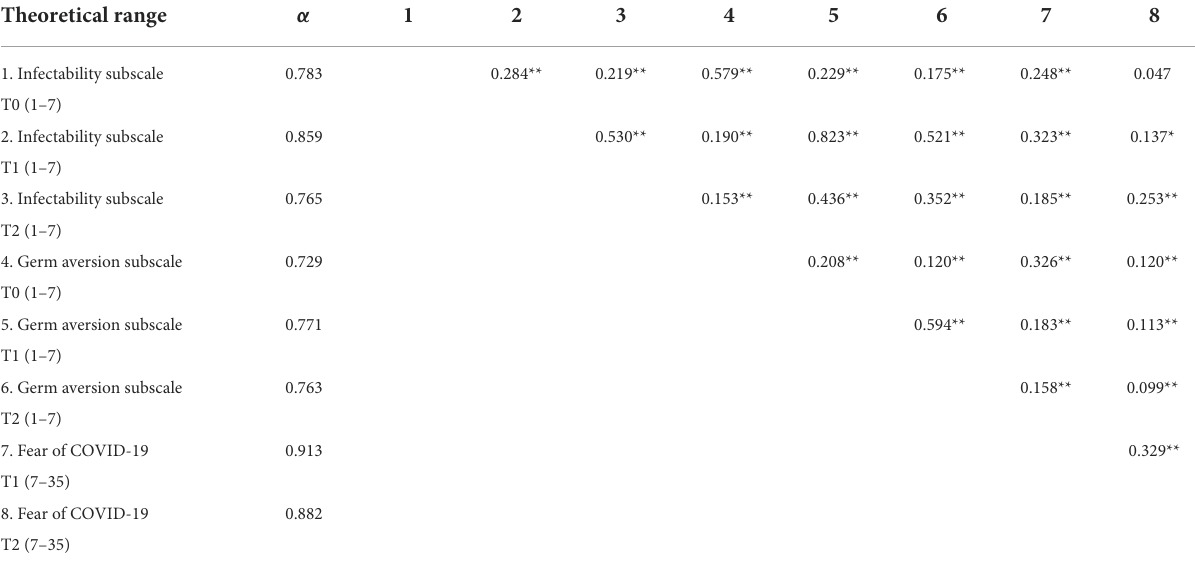
TABLE 3 Cronbach’s Alpha and intercorrelations between subscale of infectability and germ aversion (T0, T1, T2) and fear of COVID-19 (T1, T2). Theoretical